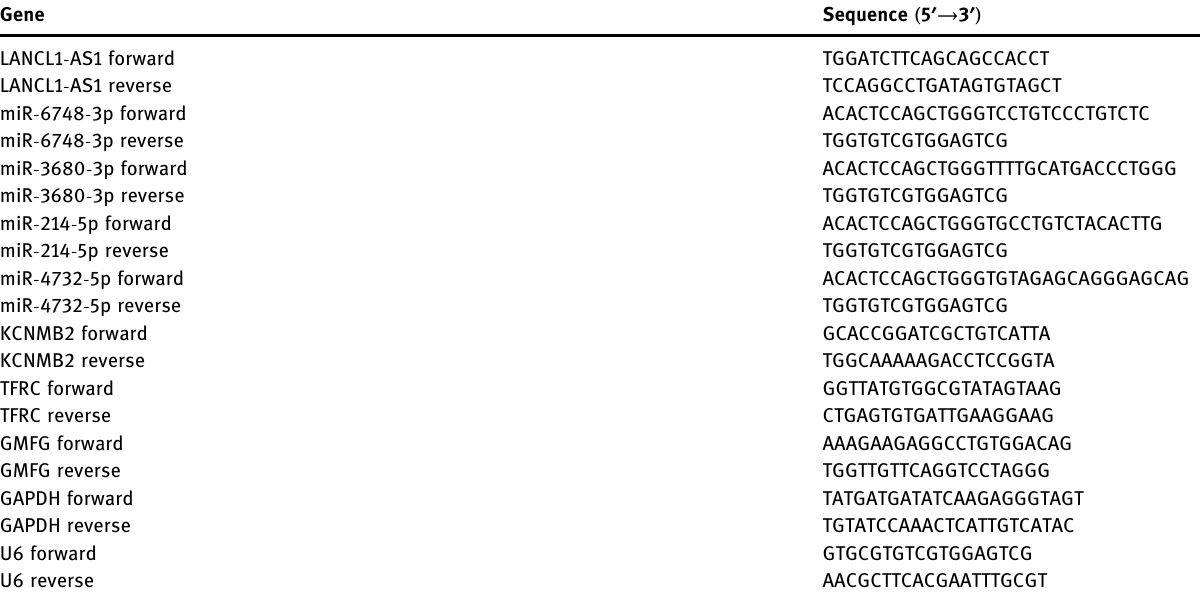
Table 1: Primer sequence used for RT - qPCR Gene Sequence ( 5 ′ → 3 ′ ) LANCL1 - AS1